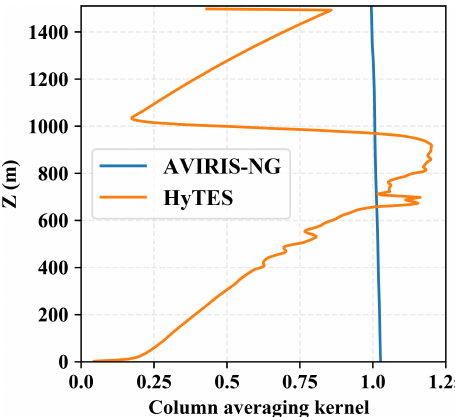
Figure 2. Column averaging kernels for two instruments, AVIRIS- NG (in blue) and HyTES (in orange), as a function of height. The altitude on the z axis is given above ground level. In the thermal case (HyTES) the flight altitude is an important factor for the CAK. The CAK of HyTES was computed for an altitude of about 3km. For the shortwave range, however, the CAK of AVIRIS-NG is not impacted significantly by flight